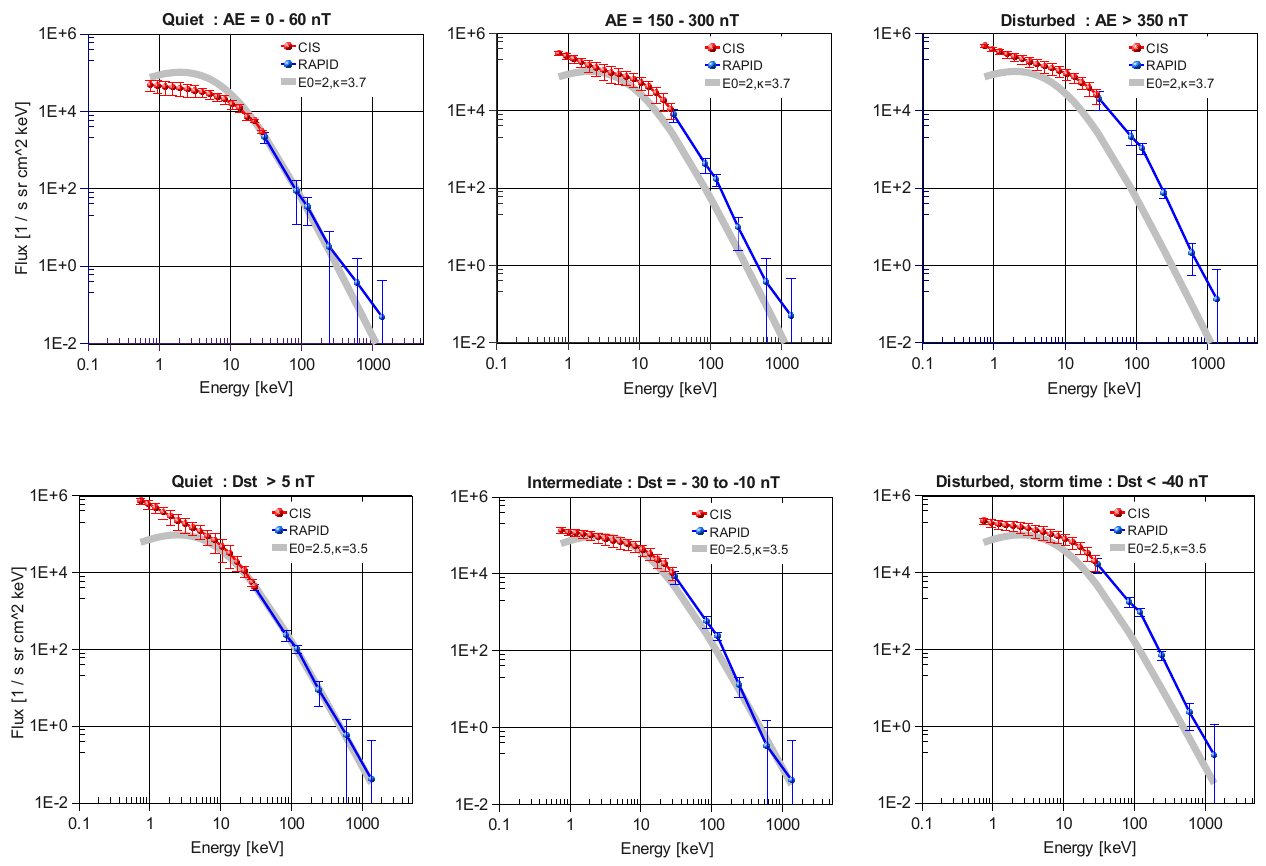
Fig. 5. Statistical proton spectra as function of geomagnetic activity. Top panels: spectrum during period with low (left), intermediate and high (right) AE index. Bottom panels: spectrum during quiet (positive Dst values – left) , intermediate Dst values (center panel) and stormtime (large negative Dst – right panel) conditions. Data for the years 2001–2004 have been used to produce these averages. The gray curve represents a visual fit to the high energy part of the leftmost spectrum in each